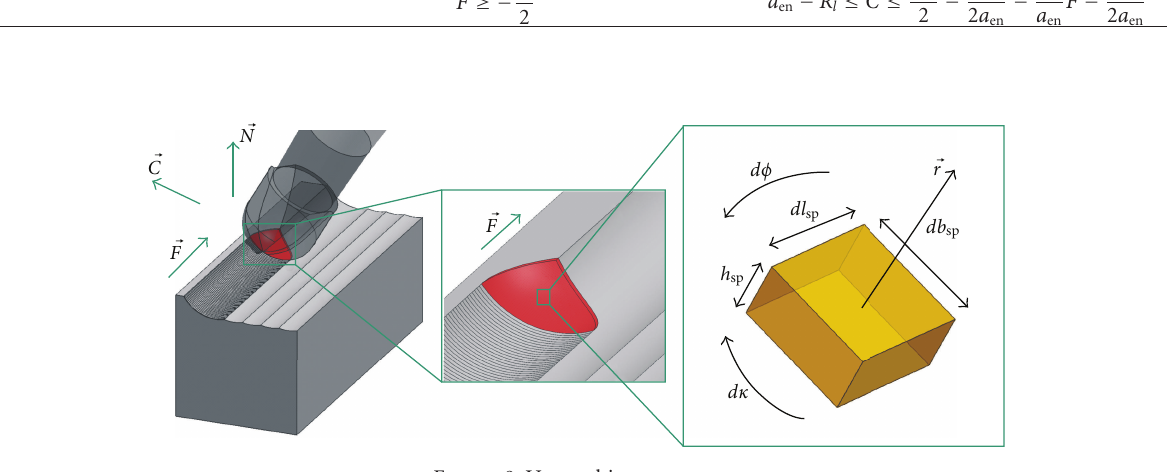
Figure 8: Uncut chip